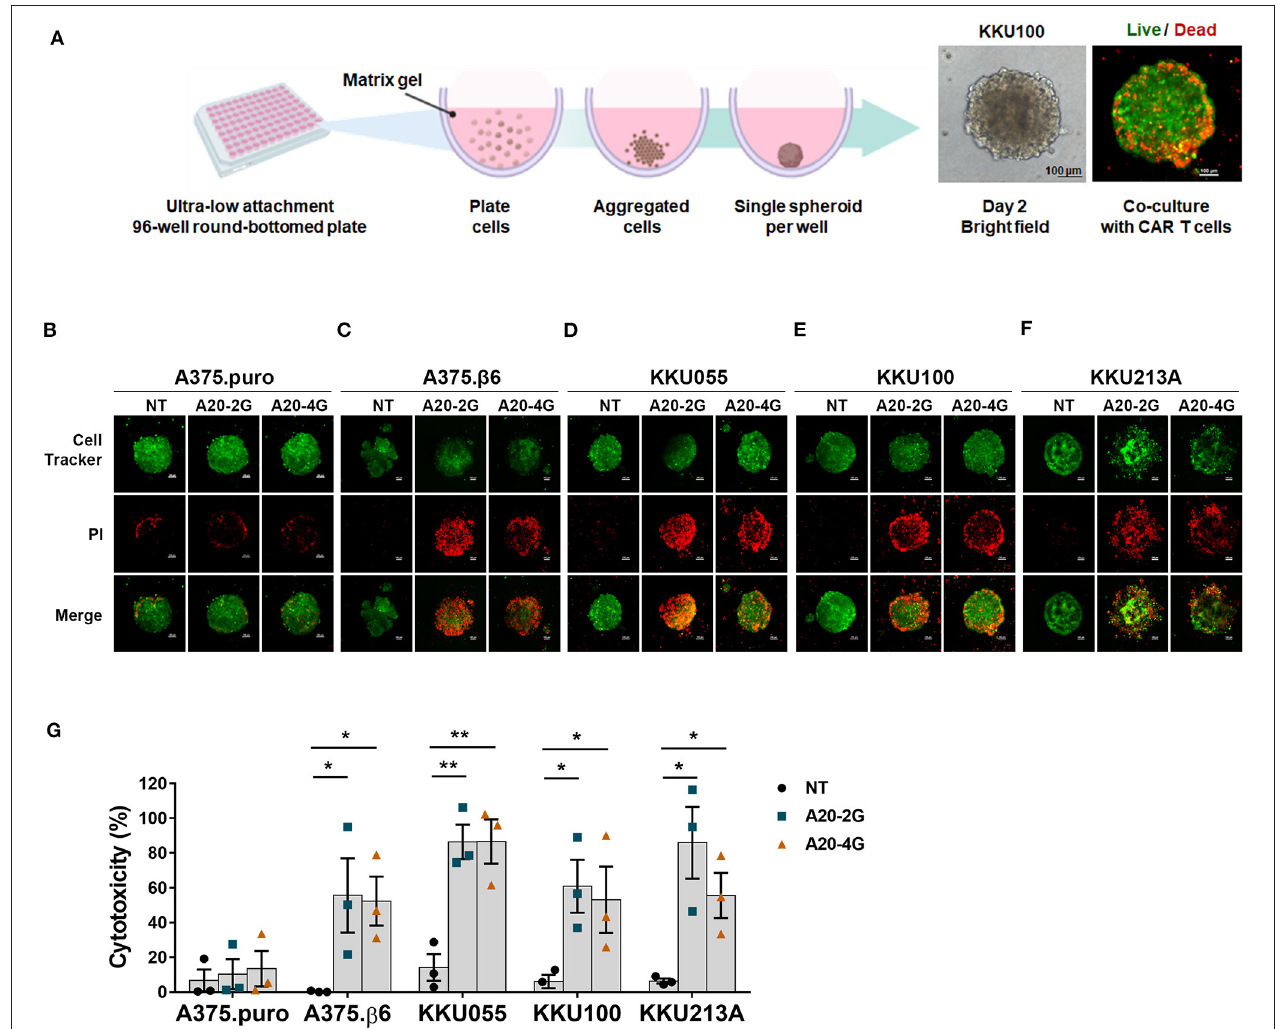
FIGURE 5 | A20-2G and A20-4G CAR T cells mediated killing of CCA tumor spheroids. (A) Schematic diagram of spheroid forming in a round-bottomed plate. Representative images on the right show bright filed of a spheroid formed by 2 × 10 3 cells for 48h and a fluorescence image after co-culturing CAR T cells with the spheroid. (B–F) Representative images showing cytolytic activities of A20-2G or A20-4G CAR T cells compared to NT cells at an effector to target (E:T) ratio of 5:1 on the spheroids of A375.puro, A375. β 6, and CCA (KKU055, KKU100, KKU213A) at 72h of co-culturing. Dead of green fluorescence-labeled cells were visualized by PI uptake (Red). (G) Histogram shows cytotoxic activities of NT cells, A20-2G CAR T cells, and A20-4G CAR T cells on tumor cells determined by PI incorporation of dead cells within spheroids. Note that lower level of the percentage of cytotoxicity of A20-4G CAR T cells for KKU213A resulted from more CCA cell lysis. The bar graphs represent mean ± standard error of the mean (SEM) (n = 3; * p < 0.05, ** p <